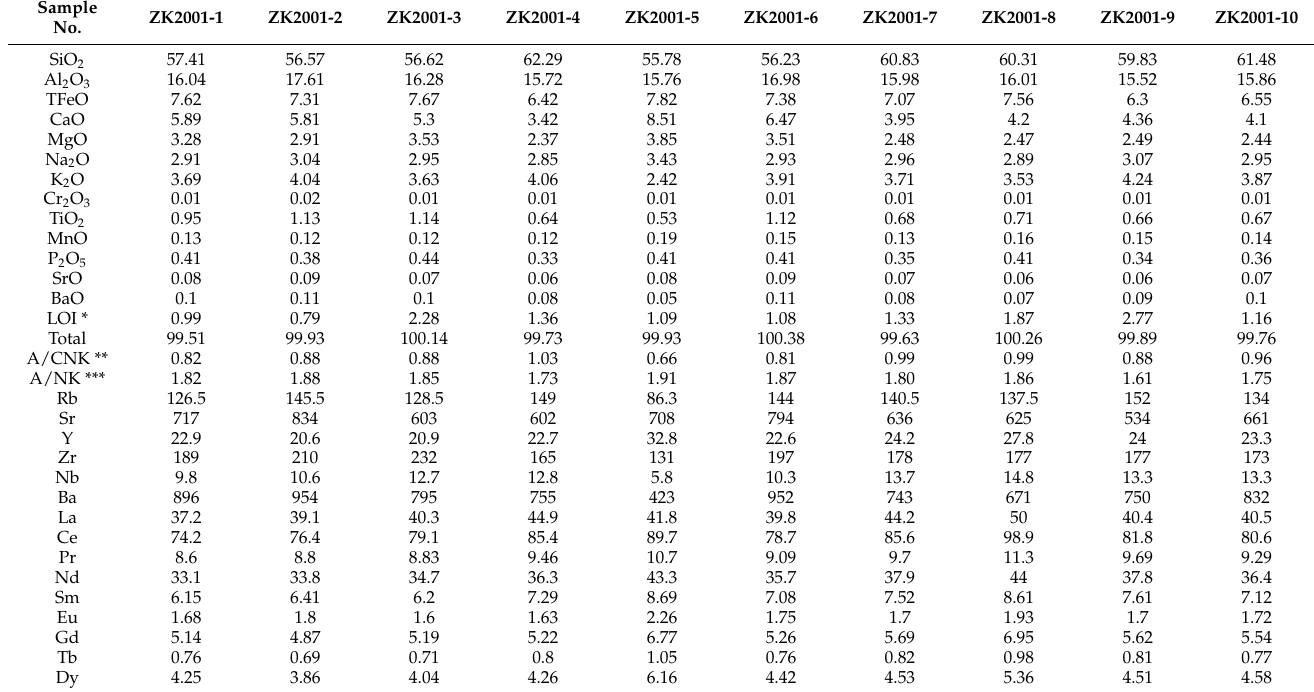
Table 3. Whole-rock major oxide (wt.%) and trace element (ppm) compositions of rocks from the No. 3 granodiorite. Sample